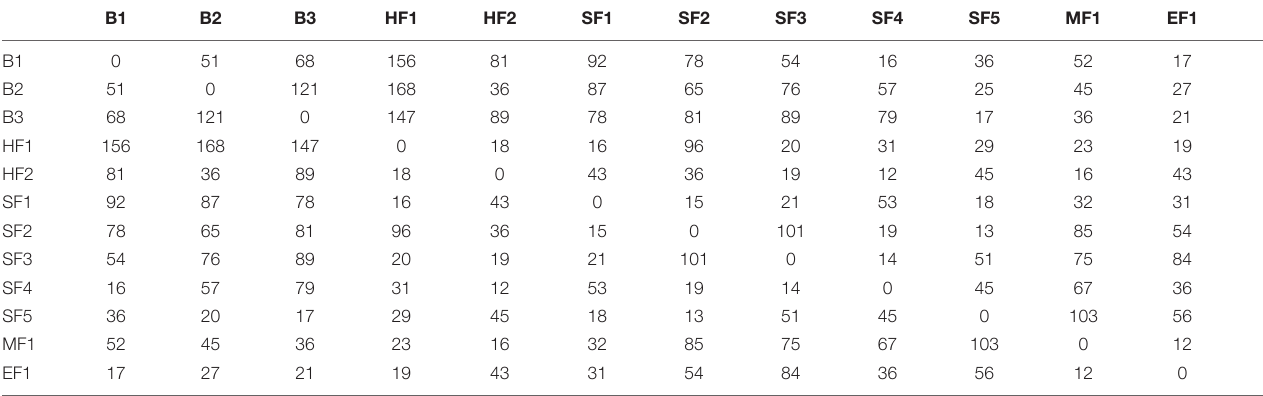
TABLE 4 | Topic co-occurrence